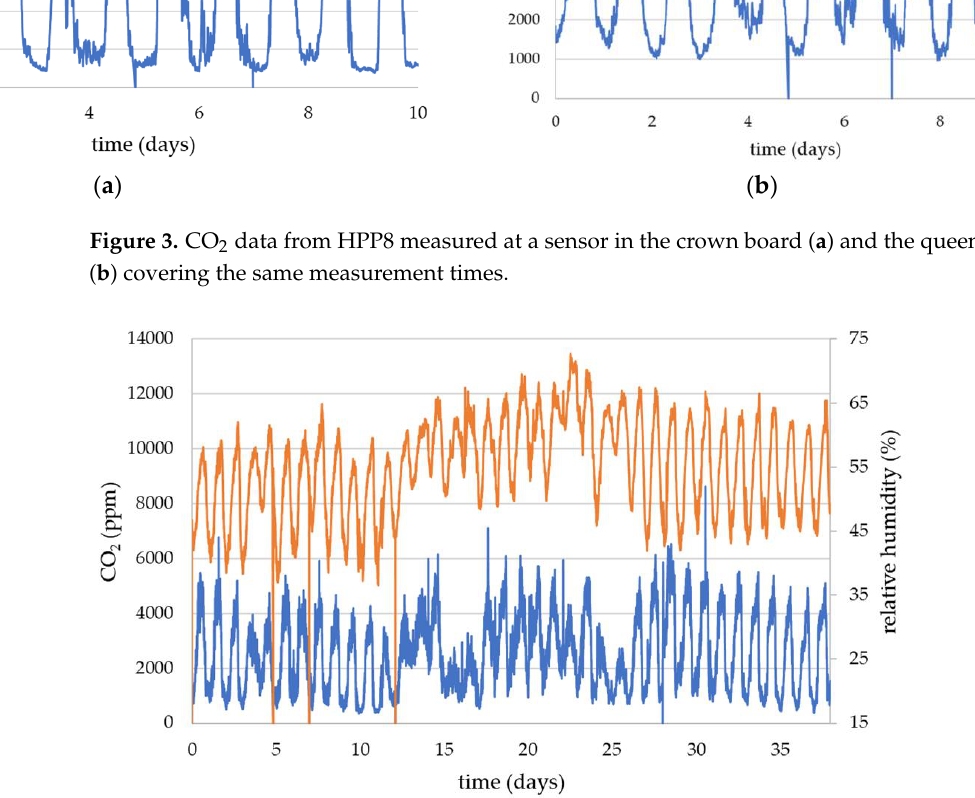
Figure 3. CO 2 data from HPP8 measured at a sensor in the crown board ( a ) and the queen excluder ( b ) covering the same measurement times.